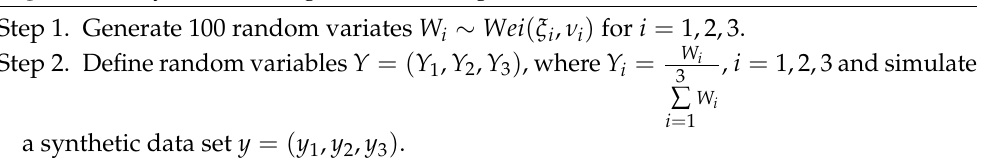
Algorithm 1 Synthetic data generation using the Weibull